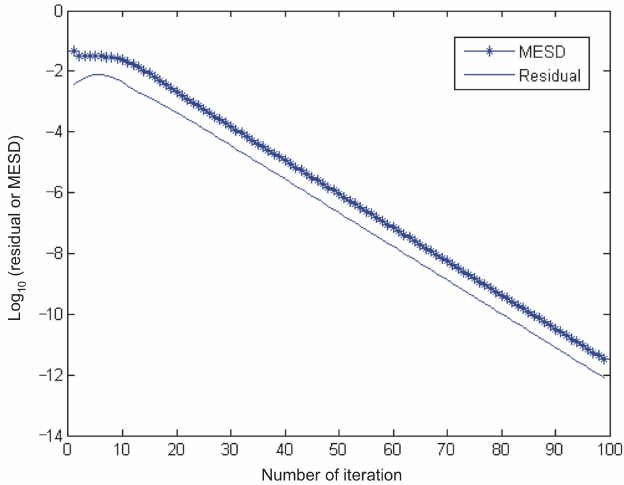
Fig. 1. Residual history for Example